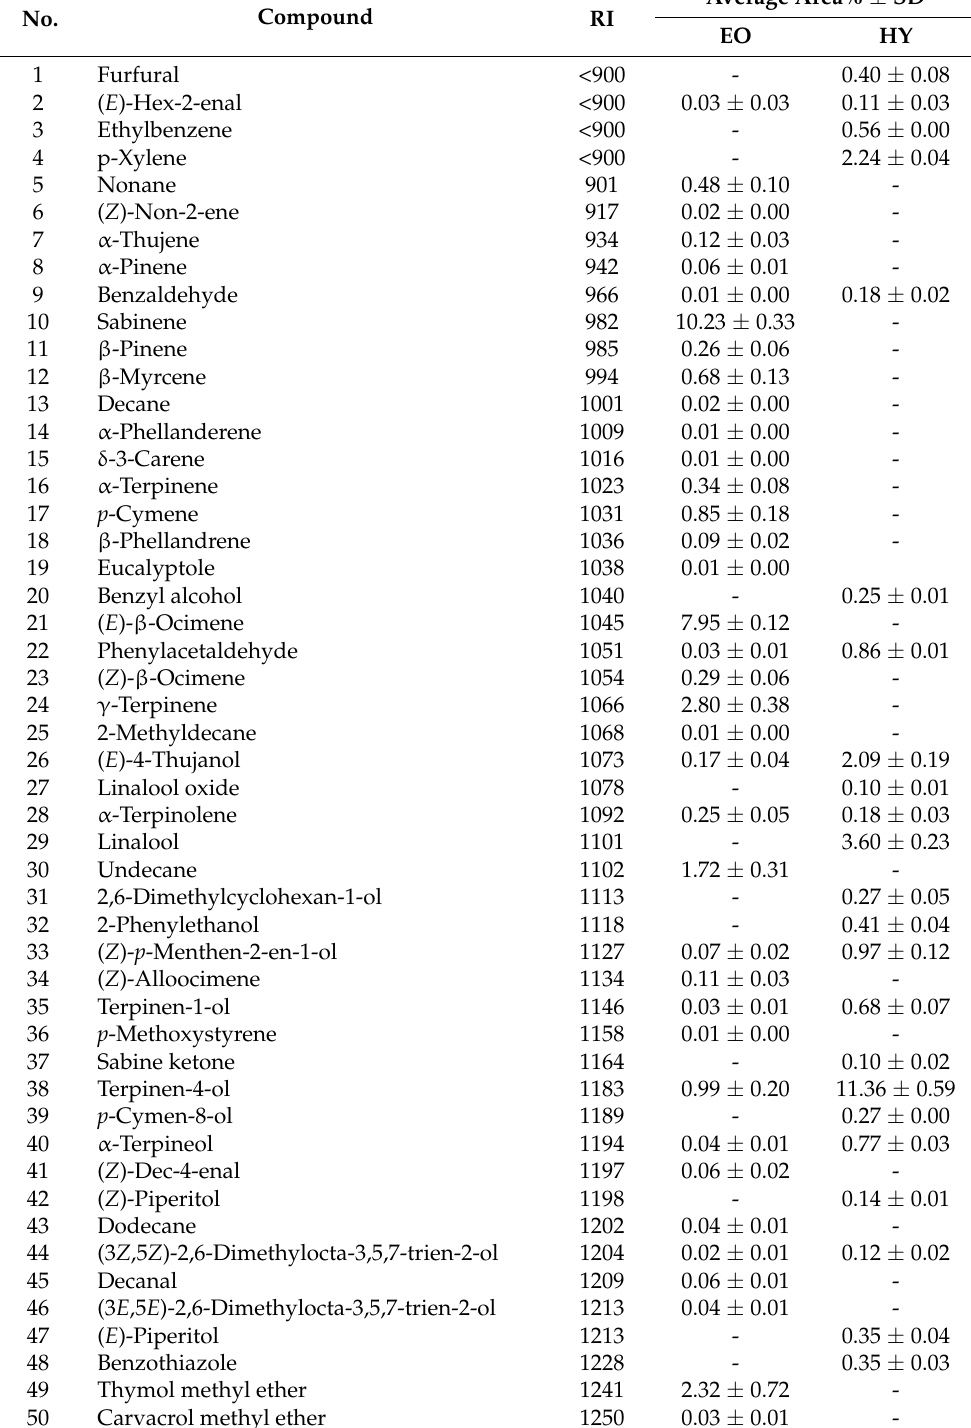
Table 1. Volatile organic compounds of air-dried P. ramosissima isolated by hydrodistillation and analyzed by gas chromatography-mass spectrometry.